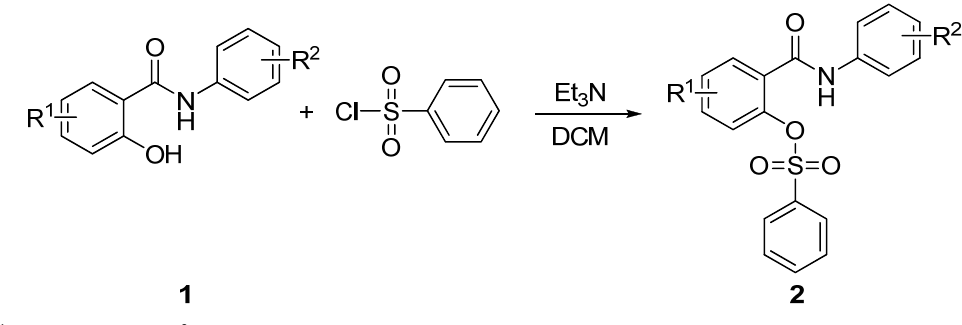
Scheme 2. Synthesis of salicylanilide